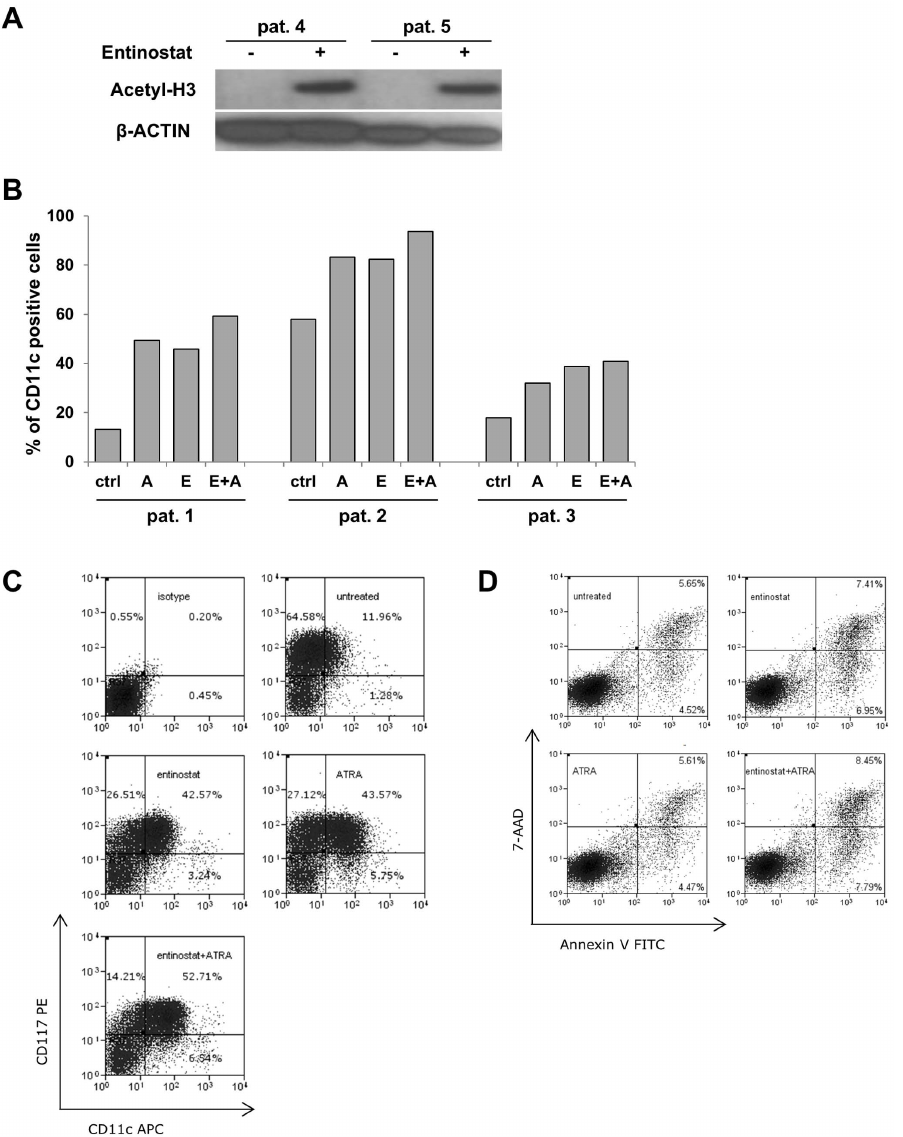
Figure 2. Effects of entinostat upon ATRA-induced differentiation and apoptosis in primary AML cells. ( A ) Effect of entinostat on histone acetylation in primary AML cells. Bone marrow samples from 2 patients with de novo , normal karyotype AML were treated ex vivo with a single pulse of 1 m M entinostat for 48 hours. Whole cell lysates were subjected to immunoblot analysis for pan-histone H3 acetylation and b -actin (loading control). ( B ) Effects on differentiation in primary AML blasts. Primary AML samples were treated with entinostat or/and ATRA ex vivo as described in Materials and Methods. Expression of the myeloid differentiation marker CD11c was quantified by flow cytometry after 48 hours of treatment. ( C ) Representative flow cytometric analysis from primary AML sample # 1. Primary AML blasts were treated with 500 nM entinostat or 1 m M ATRA alone or in combination. Forty eight hours after start of the treatment, expression of the myeloid differentiation marker CD11c and the hematopoietic progenitor cell surface marker CD117 (c-Kit) were quantified using flow cytometry. PE, phycoerythrin; APC, allophycocyanin. ( D ) Effects on apoptosis in primary AML blasts. Representative flow cytometric analysis of FITC Annexin V and 7-AAD staining from primary AML sample # 1. Primary AML blasts were treated as above. Cells were stained with FITC Annexin V and 7 AAD viability dye and analyzed by flow cytometry. Annexin V positive/7-AAD negative cells represent early apoptotic cells.